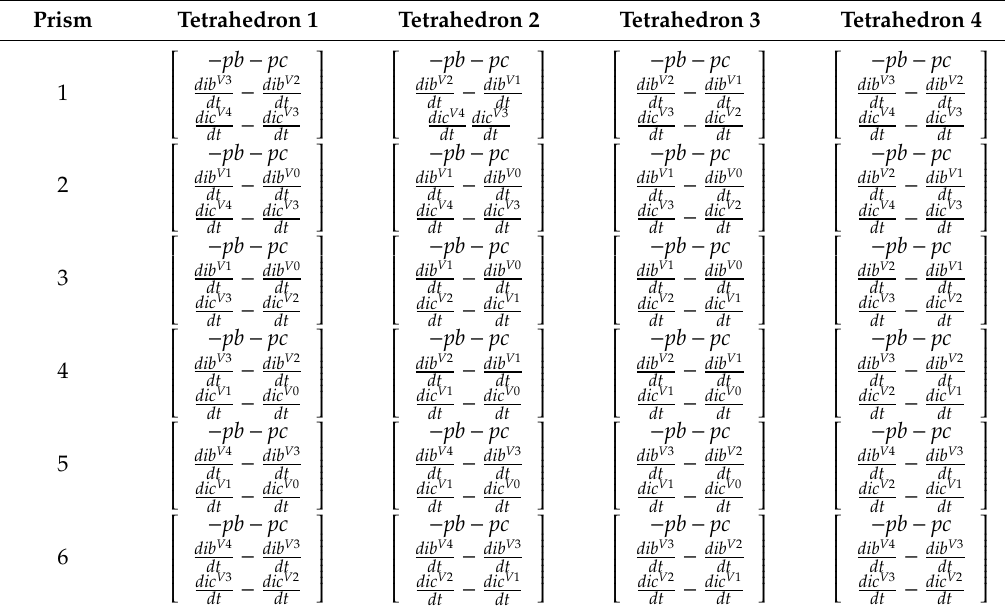
Table 6. Selection of the saturation saliency position scalars P a , P b , and P c for a fault-tolerant PMSM drive under a loss of phase “a”. Prism Tetrahedron 1 Tetrahedron 2 Tetrahedron 3 Tetrahedron